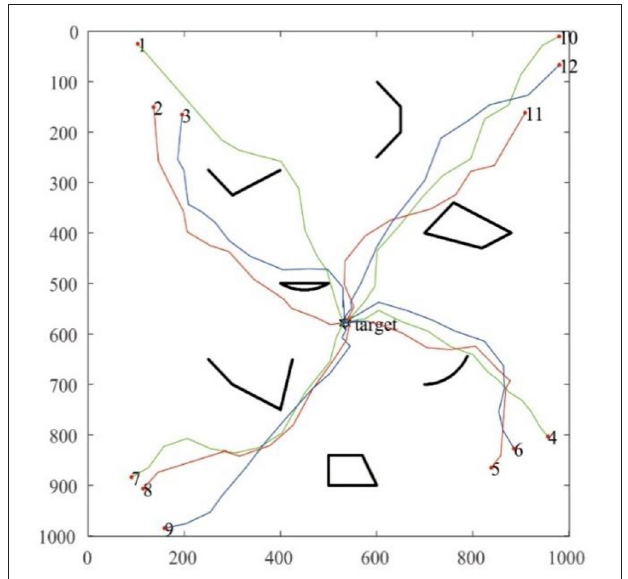
FIGURE 6 | MSRCPC single-target search path simulation